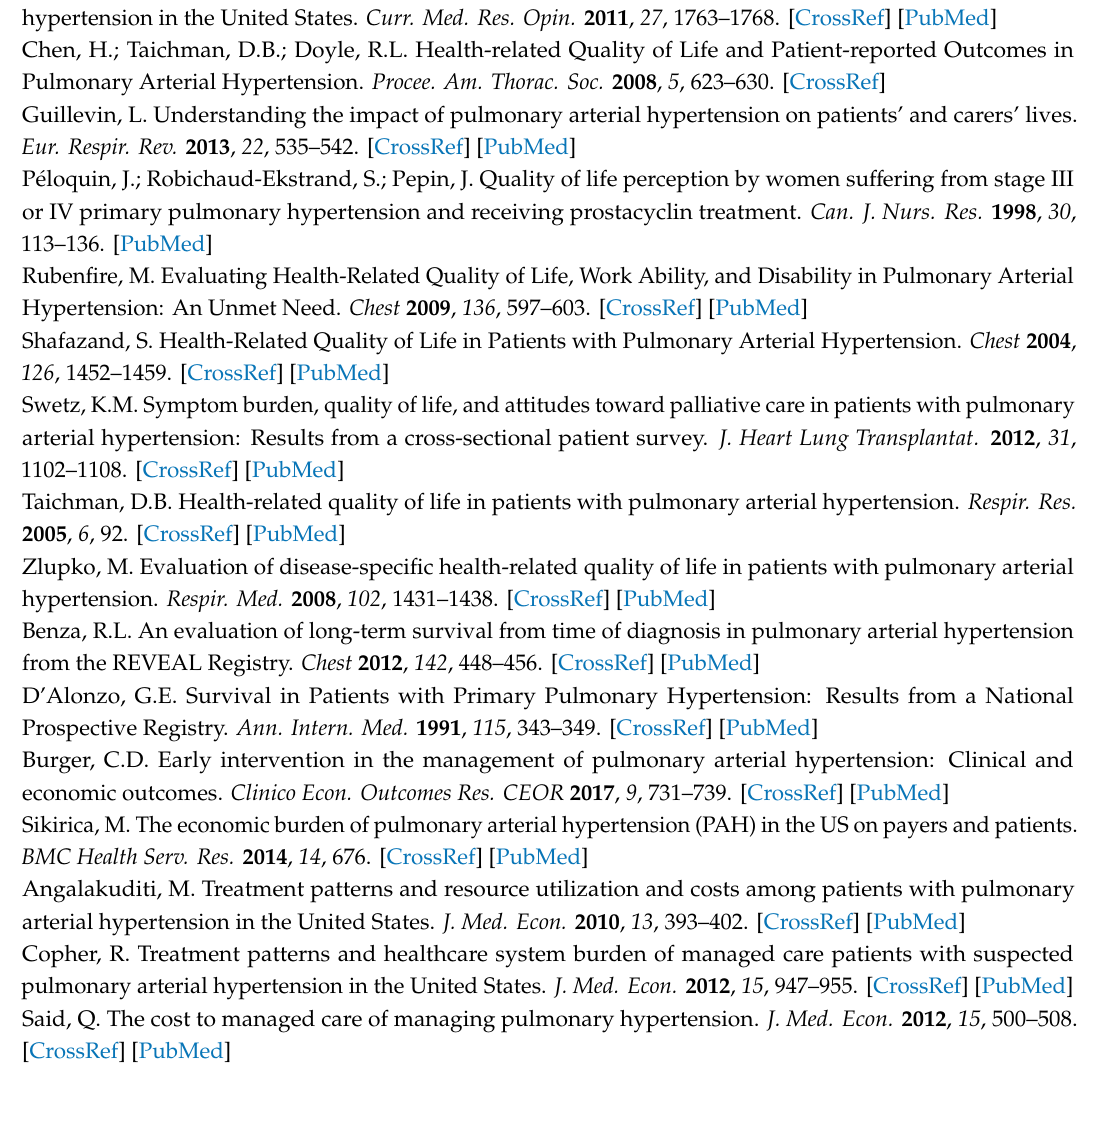
Table S1: Questionnaire for evaluating the financial burden of PAH therapy in PH patients at